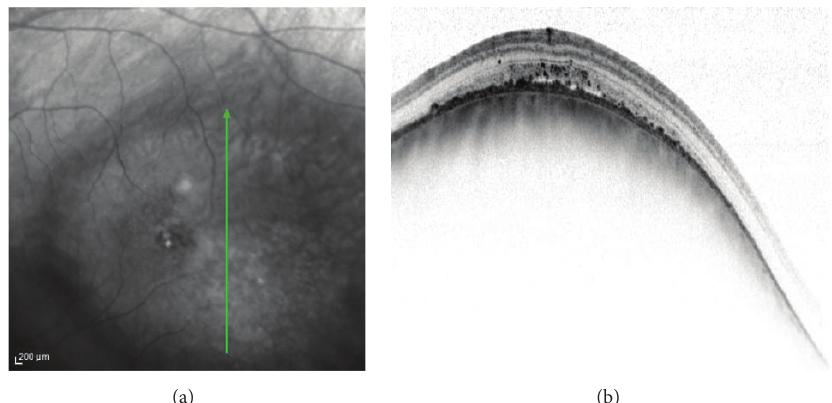
Figure 1: Left eye choroidal melanoma. The melanoma is demonstrated temporal to the macula in the infrared image (left). The vertical OCT (right) at the center of the tumor showing a smooth regular dome-shaped elevation of the choroid, irregular thickening of the RPE, limited subretinal fluid, and intraretinal hyperreflective spots.